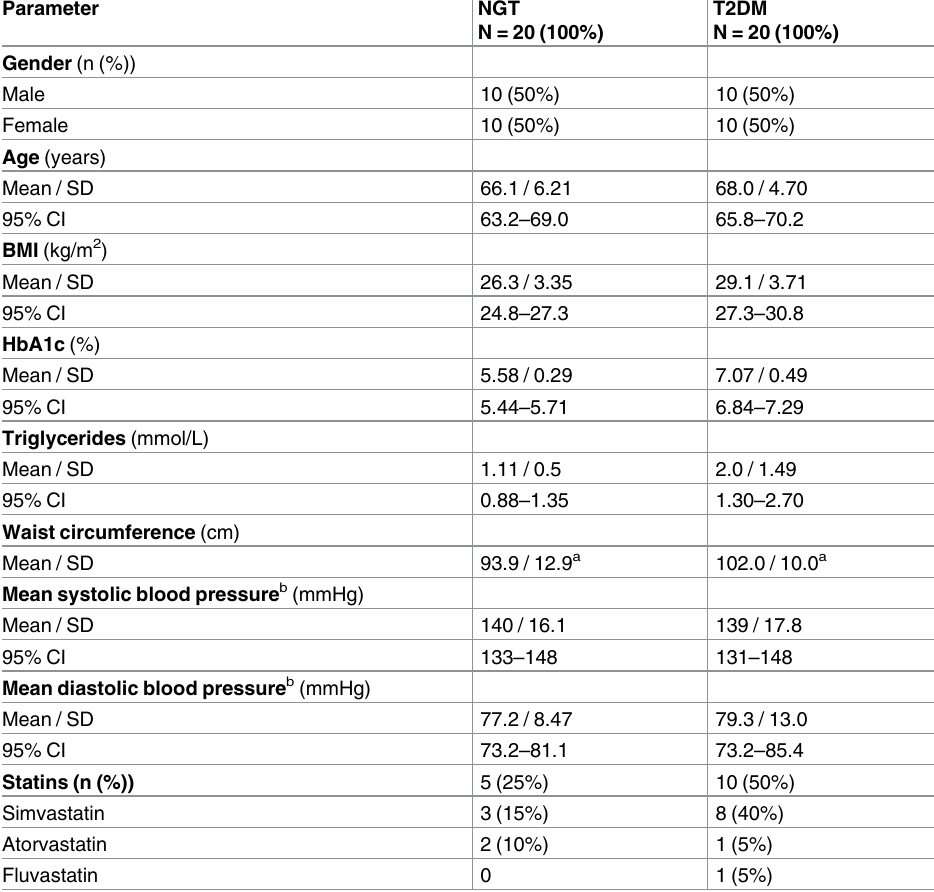
Table 1. Demographic and baseline characteristics by study group.